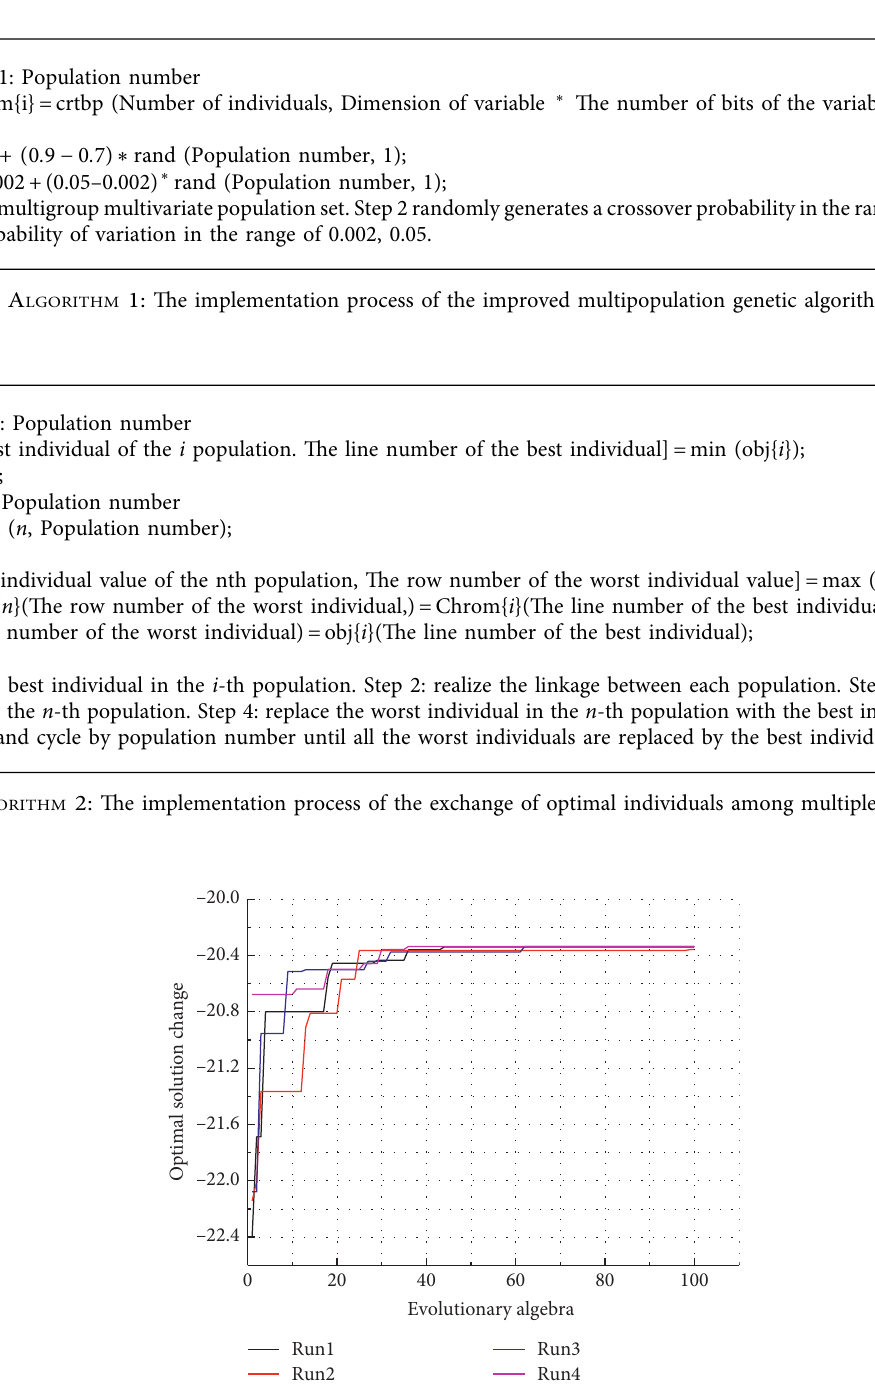
Figure 4: The evolutionary process diagram of the traditional genetic algorithm running 4